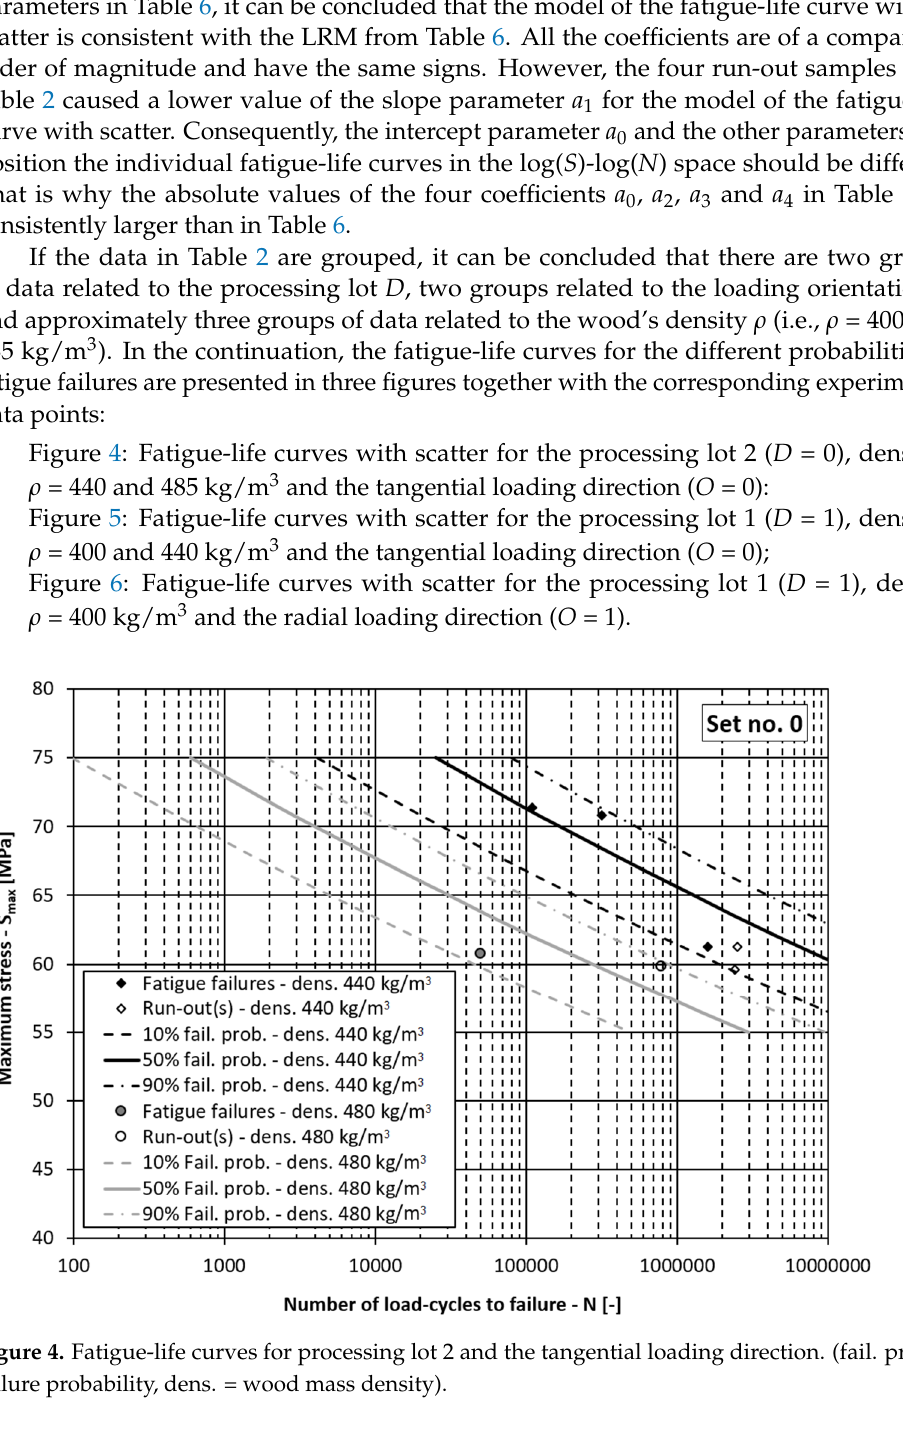
Figure 4. Fatigue-life curves for processing lot 2 and the tangential loading direction. (fail. prob. = failure probability, dens. = wood mass density).